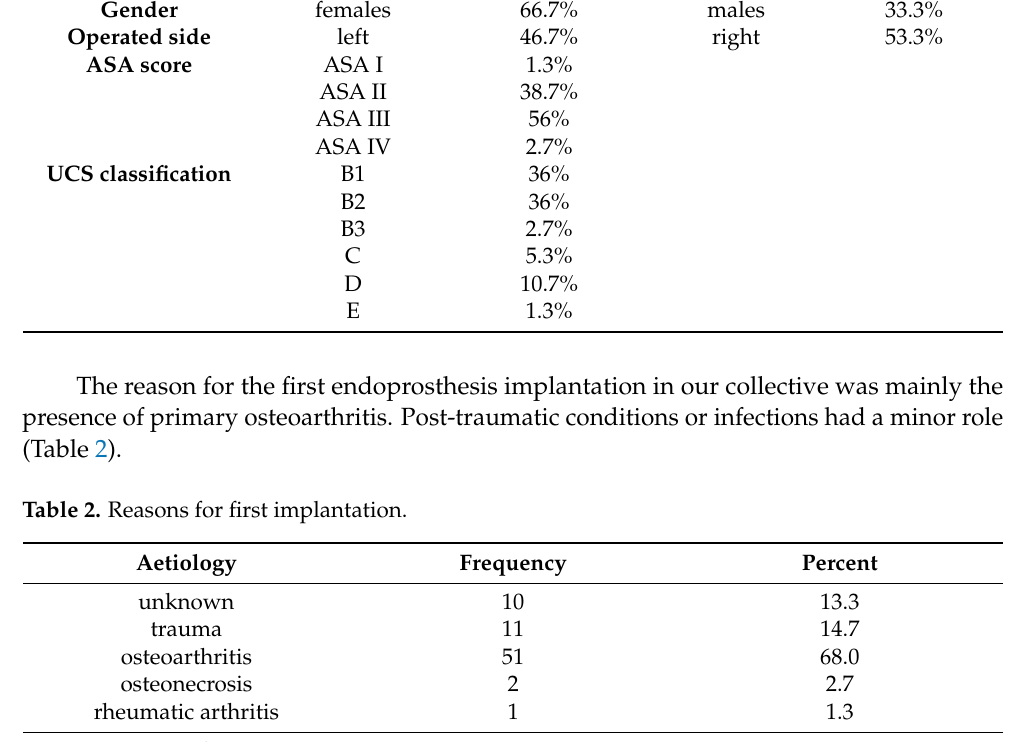
Table 2. Reasons for first implantation.